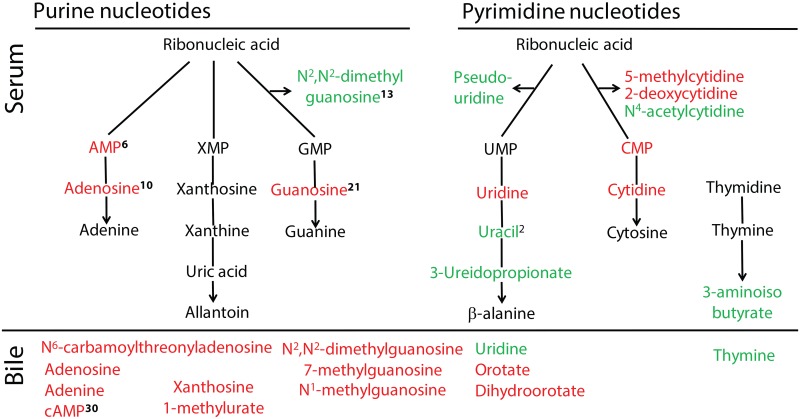
Significant differences in metabolites of ribonucleotide metabolism identified in the serum (top panel) and bile (bottom panel) of dogs with gallbladder mucocele formation compared to control dogs.Purine nucleotides are shown on the left and pyrimidine nucleotides are shown on the right. Compounds in green font were increased and compounds in red font were decreased in dogs with gallbladder mucocele formation in comparison to control dogs. Superscript numbers, when present, indicate rank of the compound as identified by Random Forest analysis as able to distinguish between control dogs and dogs with gallbladder mucocele formation.